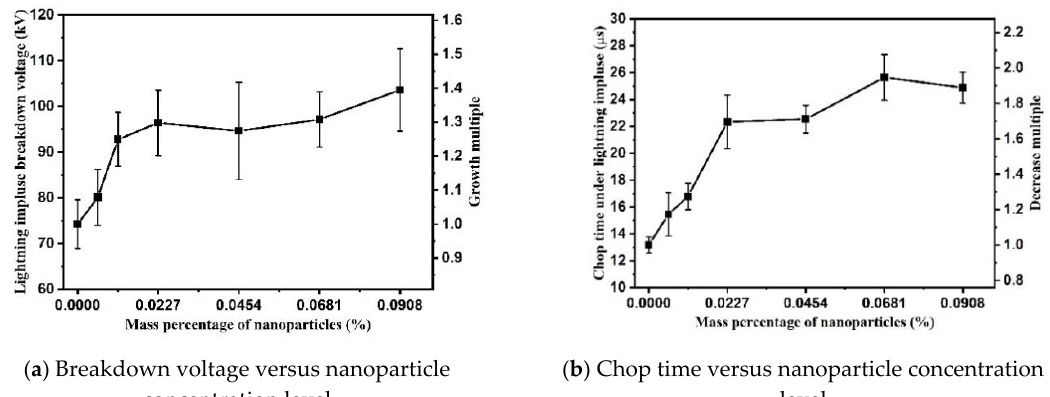
Figure 4. Positive impulse breakdown performance of TiO 2 nanofluids.